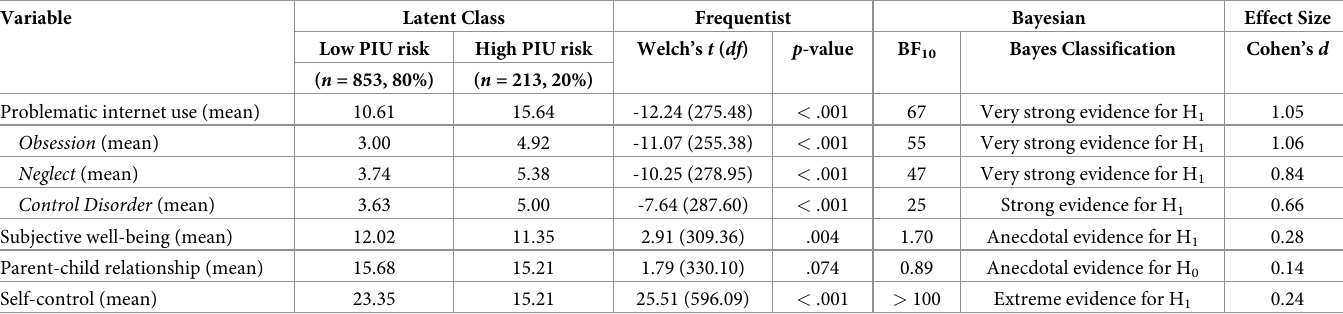
Table 3. Cross-class comparisons of high and low risk of problematic internet users for the two latent classes (N =